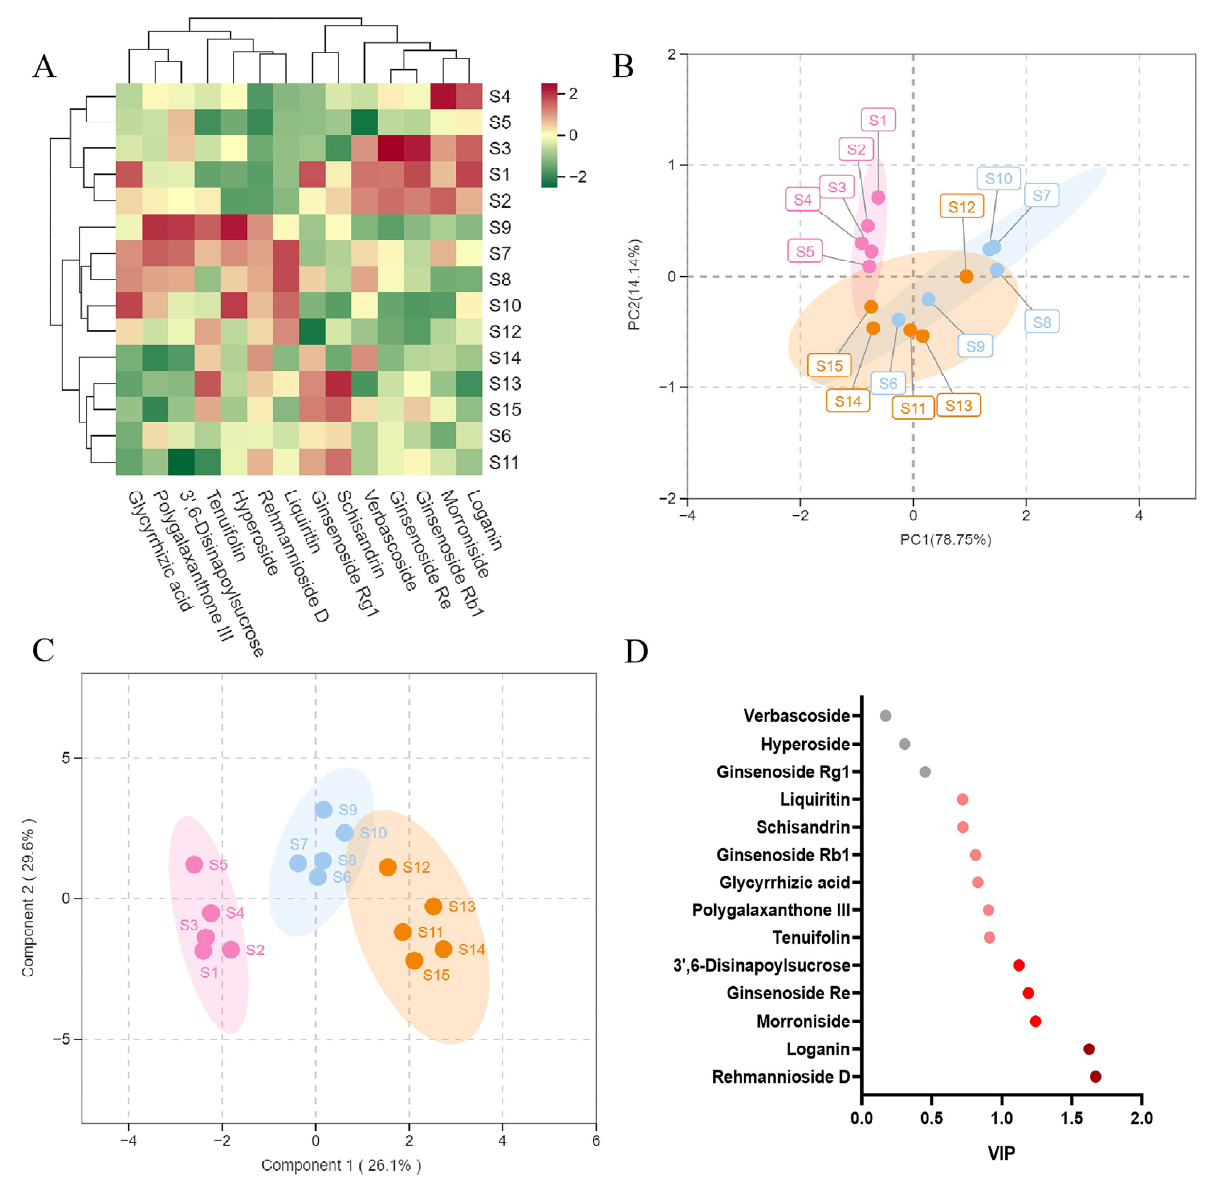
Figure 3 . Results of cluster analysis and multivariate statistical analysis for the content determina- tion of 14 analytes of fifteen batches (S1–S15) of GYJ samples. ( A ) Heat map of cluster analysis; ( B ) Results of PCA analysis; ( C ) Results of OPLS-DA analysis; ( D ) VIP Score